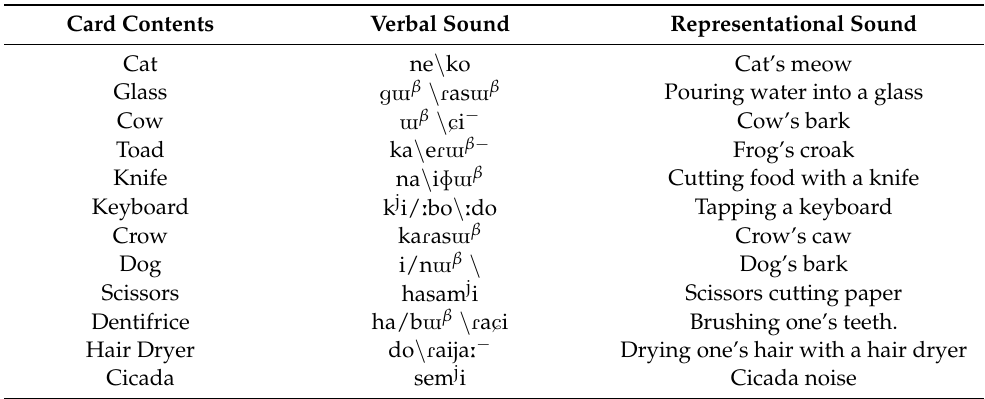
Figure 6. The state of experiment: The subject sat on the chair and described the content and position of the audible cards laid out in front of them. Table 4. Verbal Sound and representational sound sets used in the experiment. Verbal Sound sets are pronounced in Japanese, and written in international phonetic